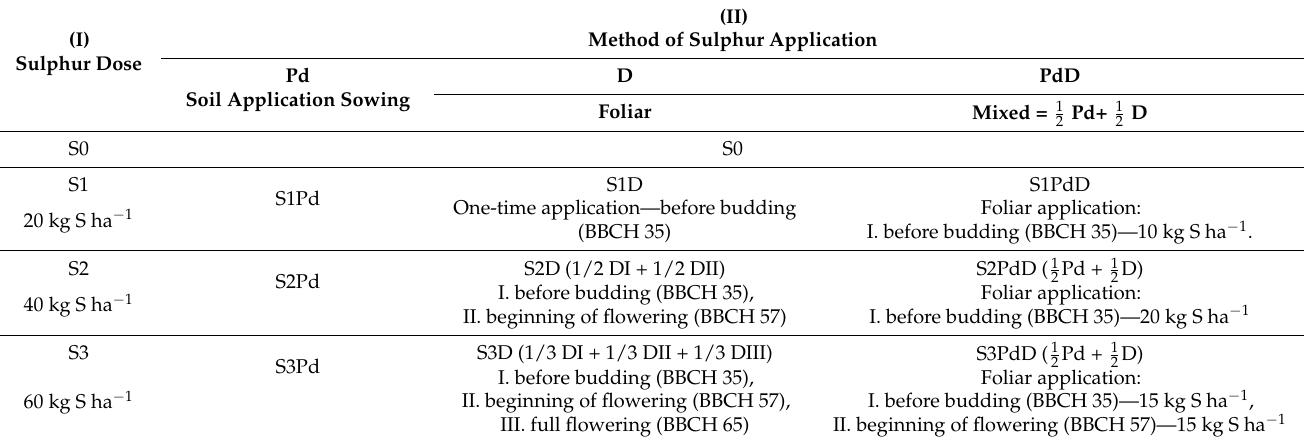
Table 2. Applied variants of sulphur